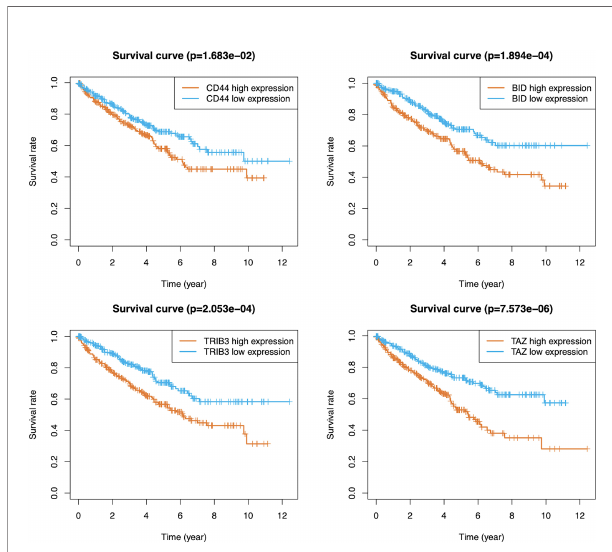
FIGURE 4 | K-M survival analysis of CD44, BID, TRIB3 and TAZ in the TCGA database. K-M, Kaplan – Meier.